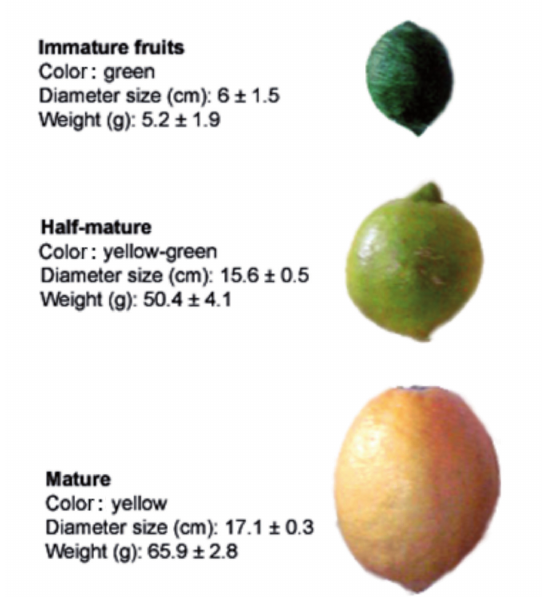
Fig. 1: Color, diameter and weight of lemon fruits at different maturity stages Chemicals and